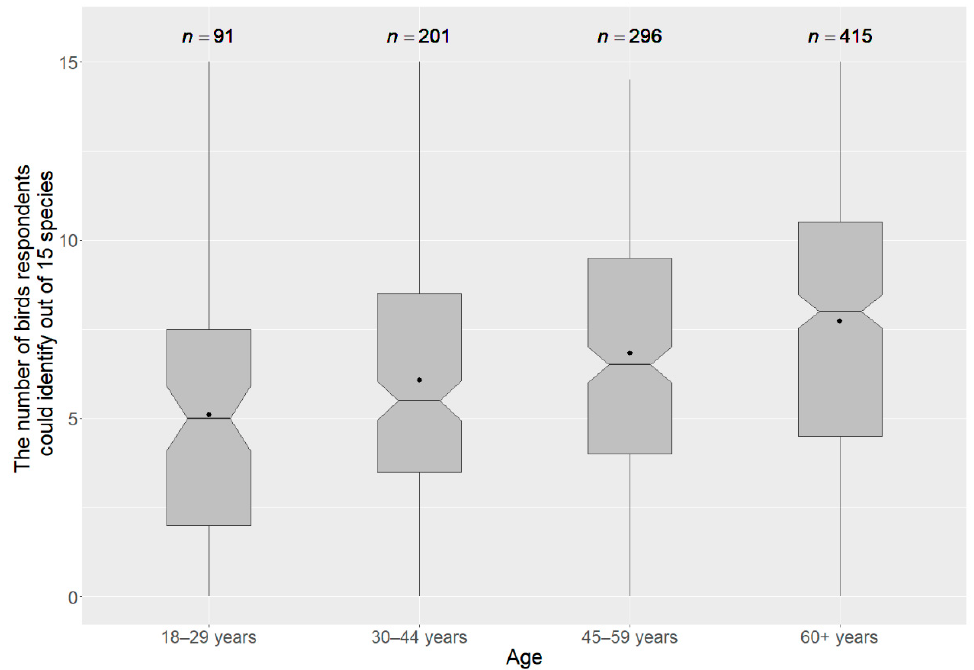
Figure 1. Bird species knowledge with standard deviation in error bars by participants of different age groups. Lower end of the boxplot shows the first quartile, the median is indicated by a line in the notch (95% confidence interval of the median) and the 75% quartile is marked by the upper end of the boxplot. The dot within the boxplot indicates the mean score.